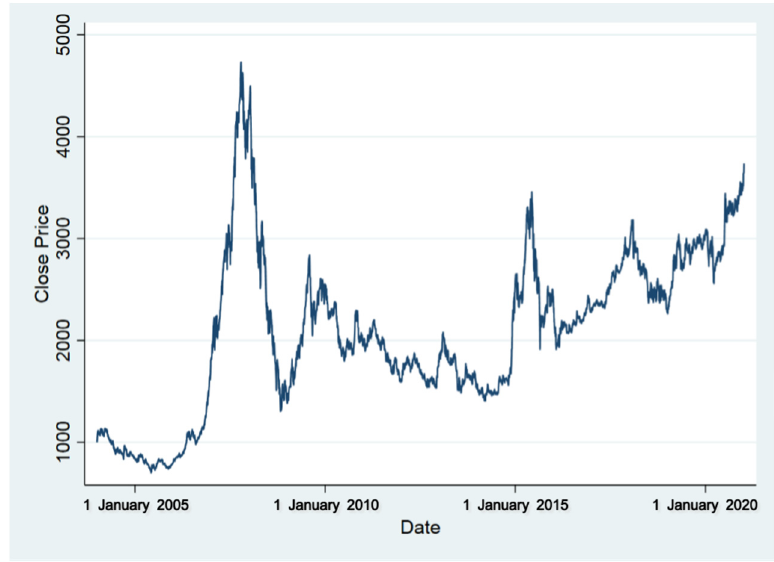
Figure 2. Time series of SSE 50 index.